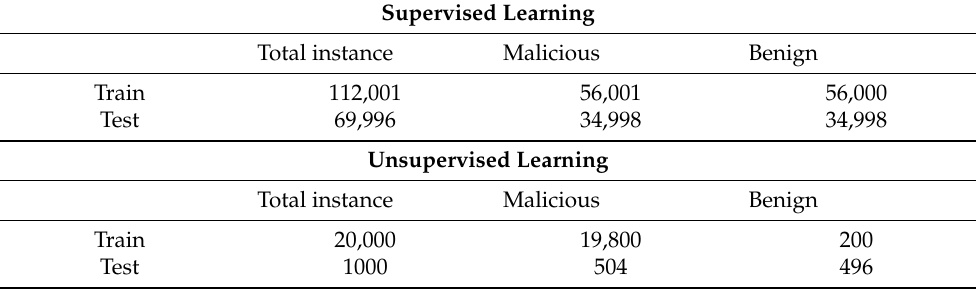
Table 2. Dataset